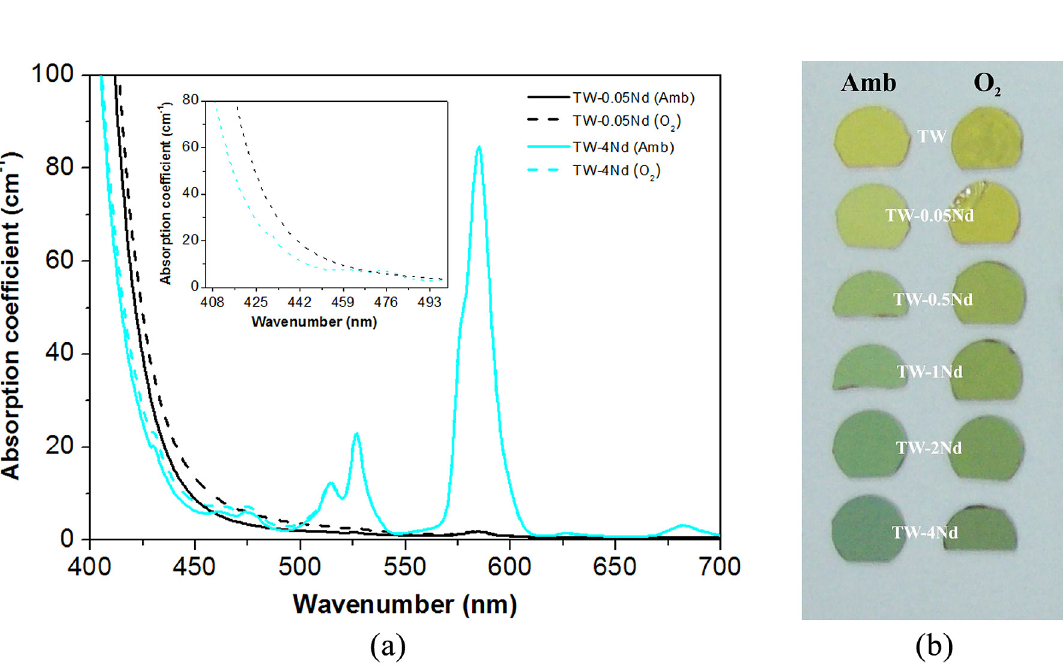
*The density error is